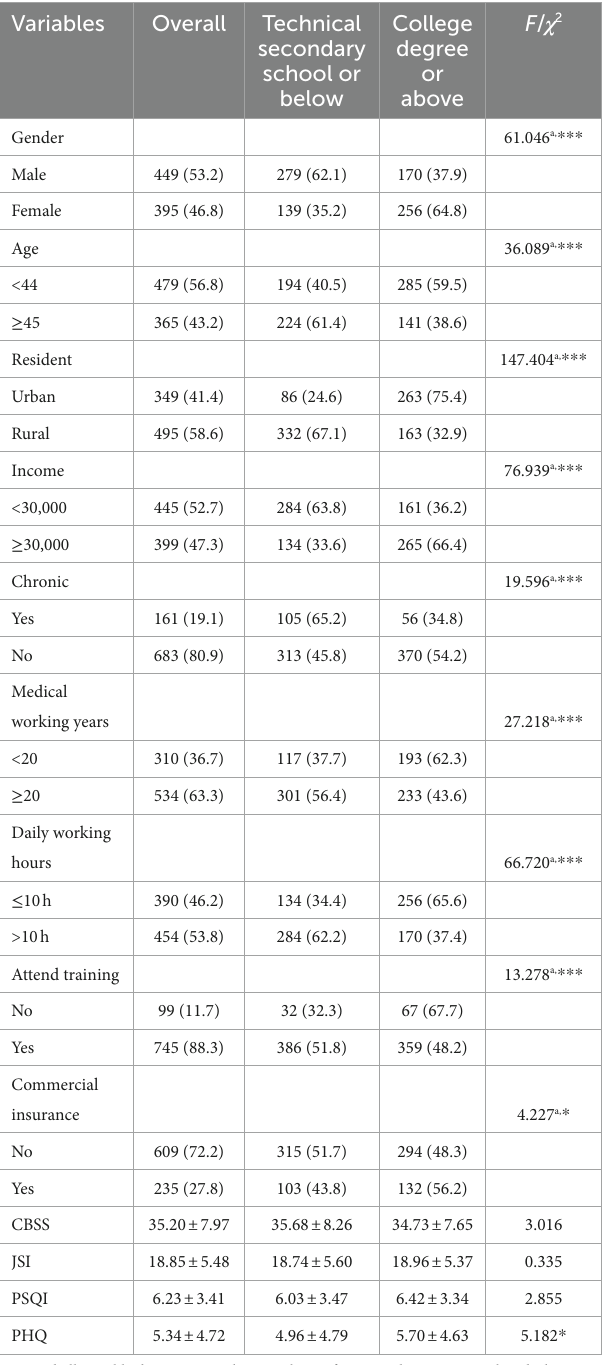
TABLE 1 Description and univariate analysis among different educational